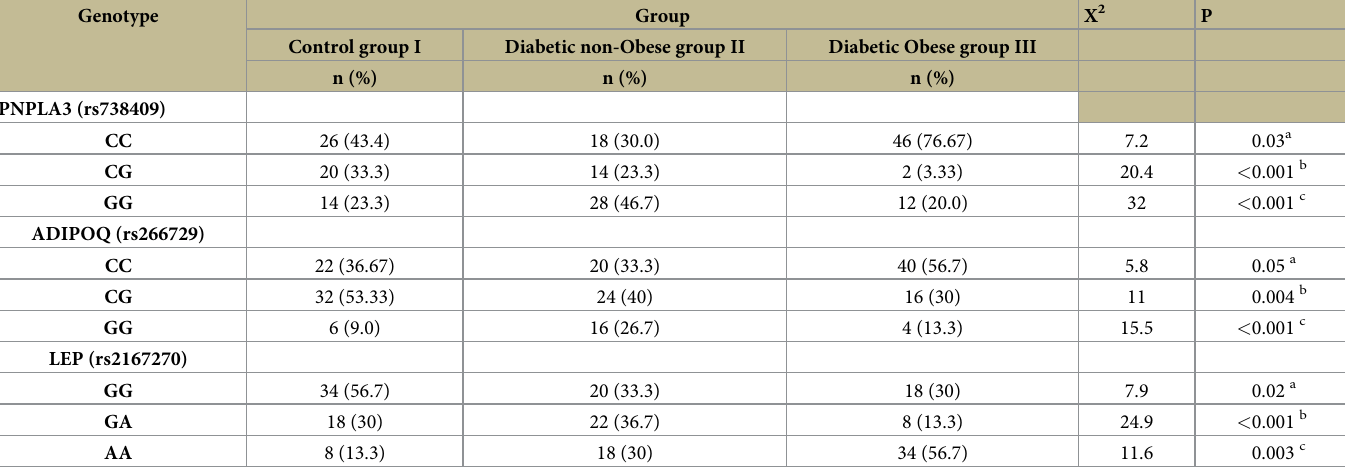
Table 4. Distribution of genotypes of PNPLA3 (rs738409) C > G, ADIPOQ rs266729 G > C and LEP rs2167270 G > A among cases and control groups.